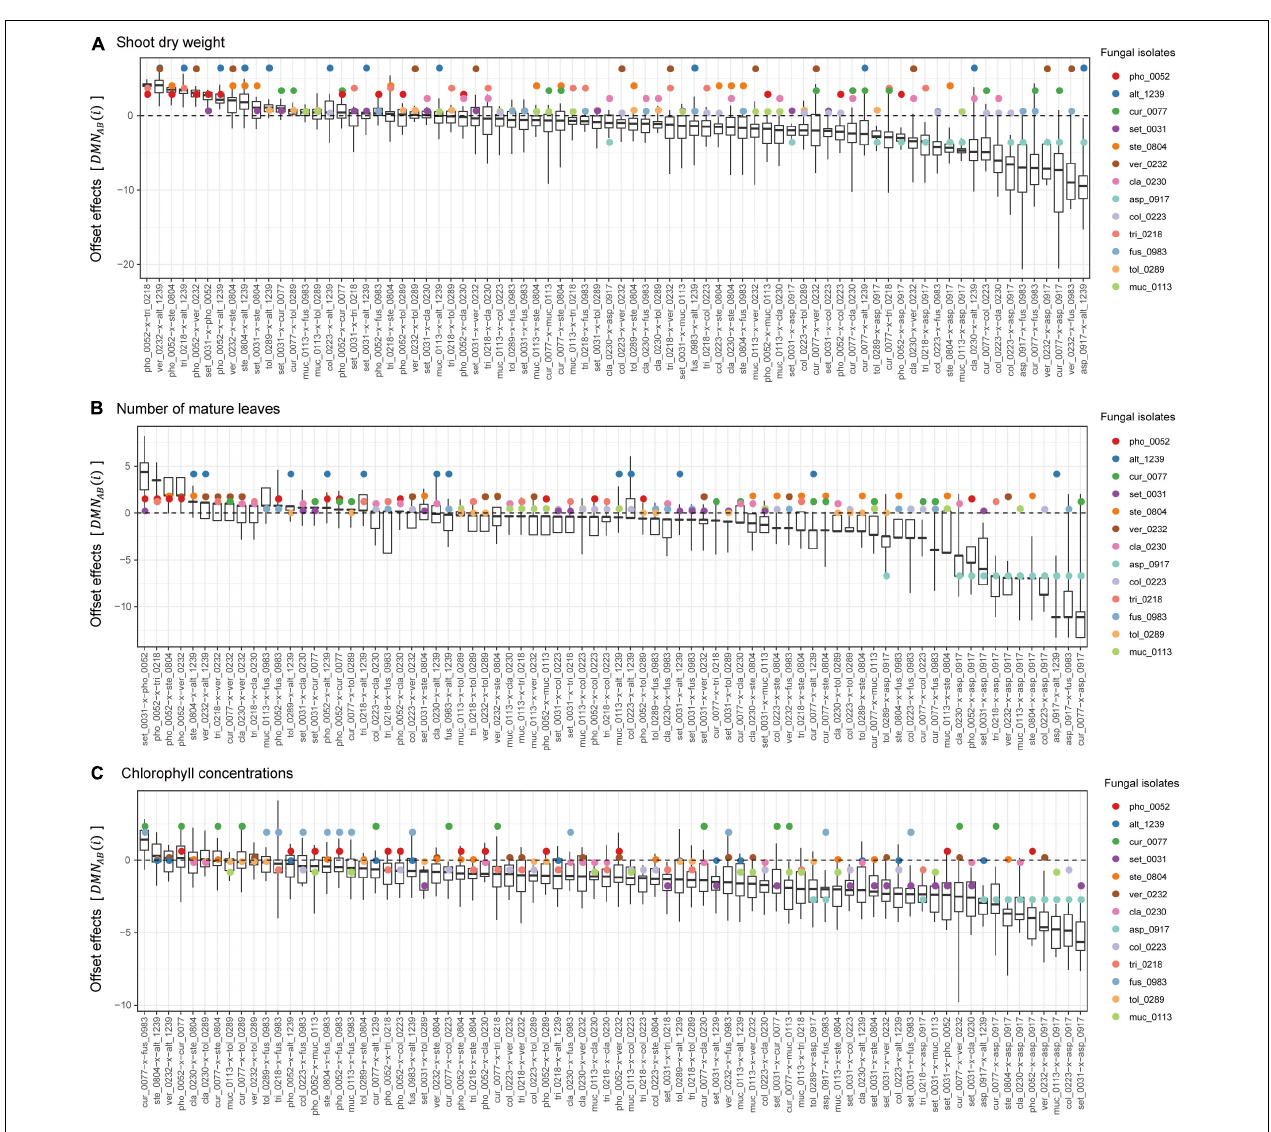
FIGURE 5 | Offset effects observed in dual-inoculation experiments. (A) Offset effect index in terms of shoot dry weight. The index representing deviation of dual-inoculation effects from the minimum effects in single inoculations are shown for each pair of fungal isolates. Circles represent single-inoculation effects of respective fungal isolates. (B) Offset effect index in terms of the number of mature leaves. (C) Offset effect index in terms of chlorophyll